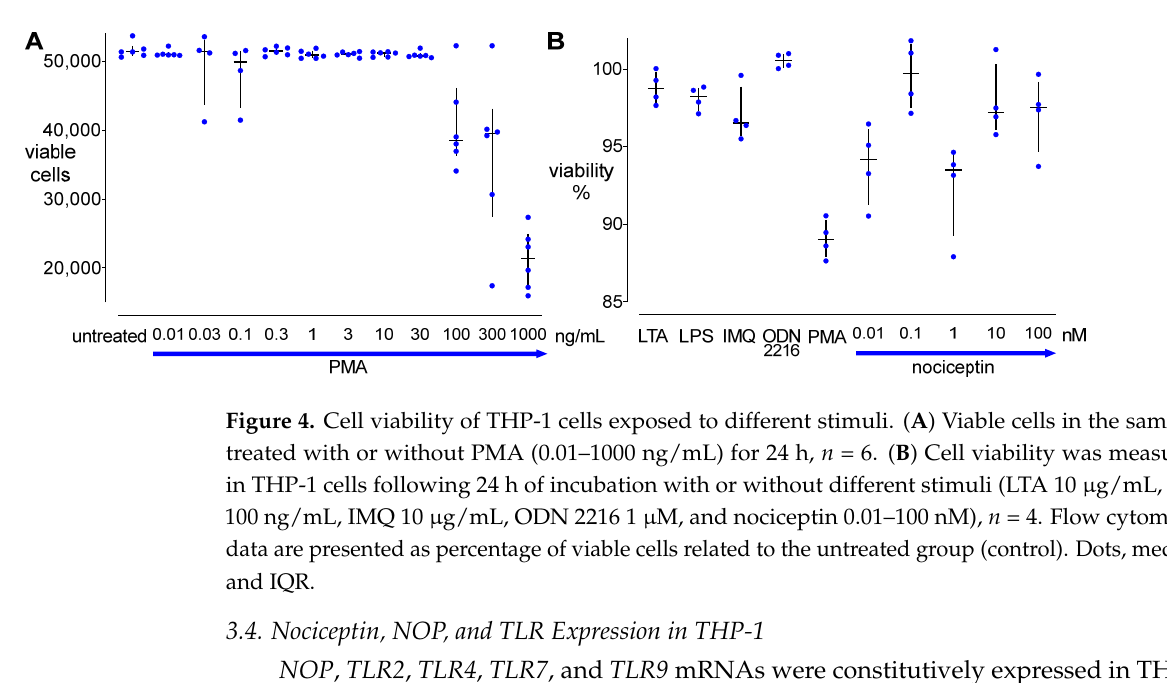
Figure 5. Constitutive nociceptin, NOP, TLR expression patterns in THP ‐ 1 cells. ( A ) Basal levels of ppNOC , NOP , TLR2 , TLR4 , TLR7 , and TLR9 mRNA expression. ( B ) Basal levels of nociceptin, NOP, and TLR proteins. (C) Representative histogram plots of cell membrane NOP, TLR2, TLR4, and in ‐ tracellular nociceptin, and TLR7 and TLR9 protein levels. Cells were stained with specific antibodies for nociceptin, NOP, TLR2, TLR4, TLR7, or TLR9 (blue ‐ filled histogram). The grey ‐ filled histogram represents samples stained with respective isotype control antibodies. Flow cytometry data are pre ‐ sented as mean fluorescence intensity (MFI) related to the respective isotype controls. Boxplots with individual data points, median, IQR, and mean “+”; n = 6.